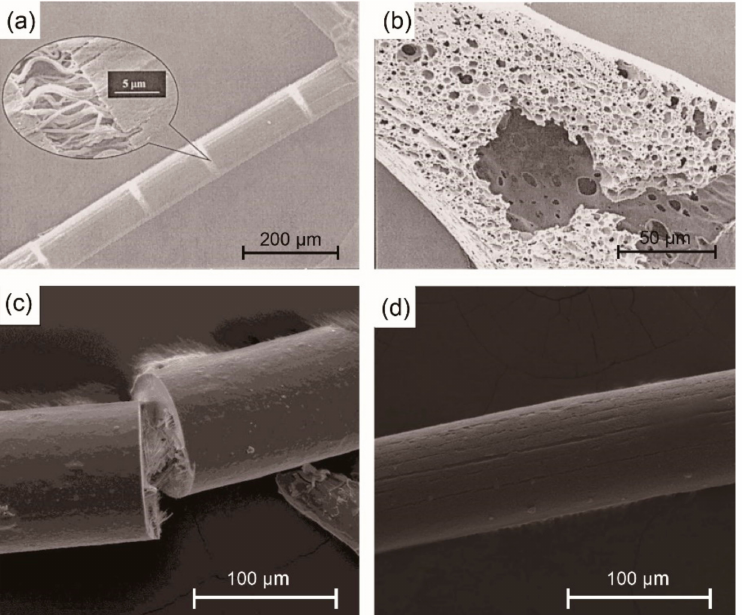
Figure 5. Scanning electron microscopic (SEM) images of melt-spun lignin/PP ( w/w 75/25) fibers: ( a ) as-spun fibers after stretching to produce fractures along the fiber axis and ( b ) thermally treated fibers after being cut at a 30 ◦ angle with respect to the fiber axis; ( c ) butyrated lignin/PLA fiber ( w/w 75/25) and ( d ) corresponding lignin/PLA carbon fiber by melt spinning. ( a , b ) Reproduced with permission from [113], copyright 2002 John Wiley and Sons. ( c , d ) From [101], an open-access thesis.